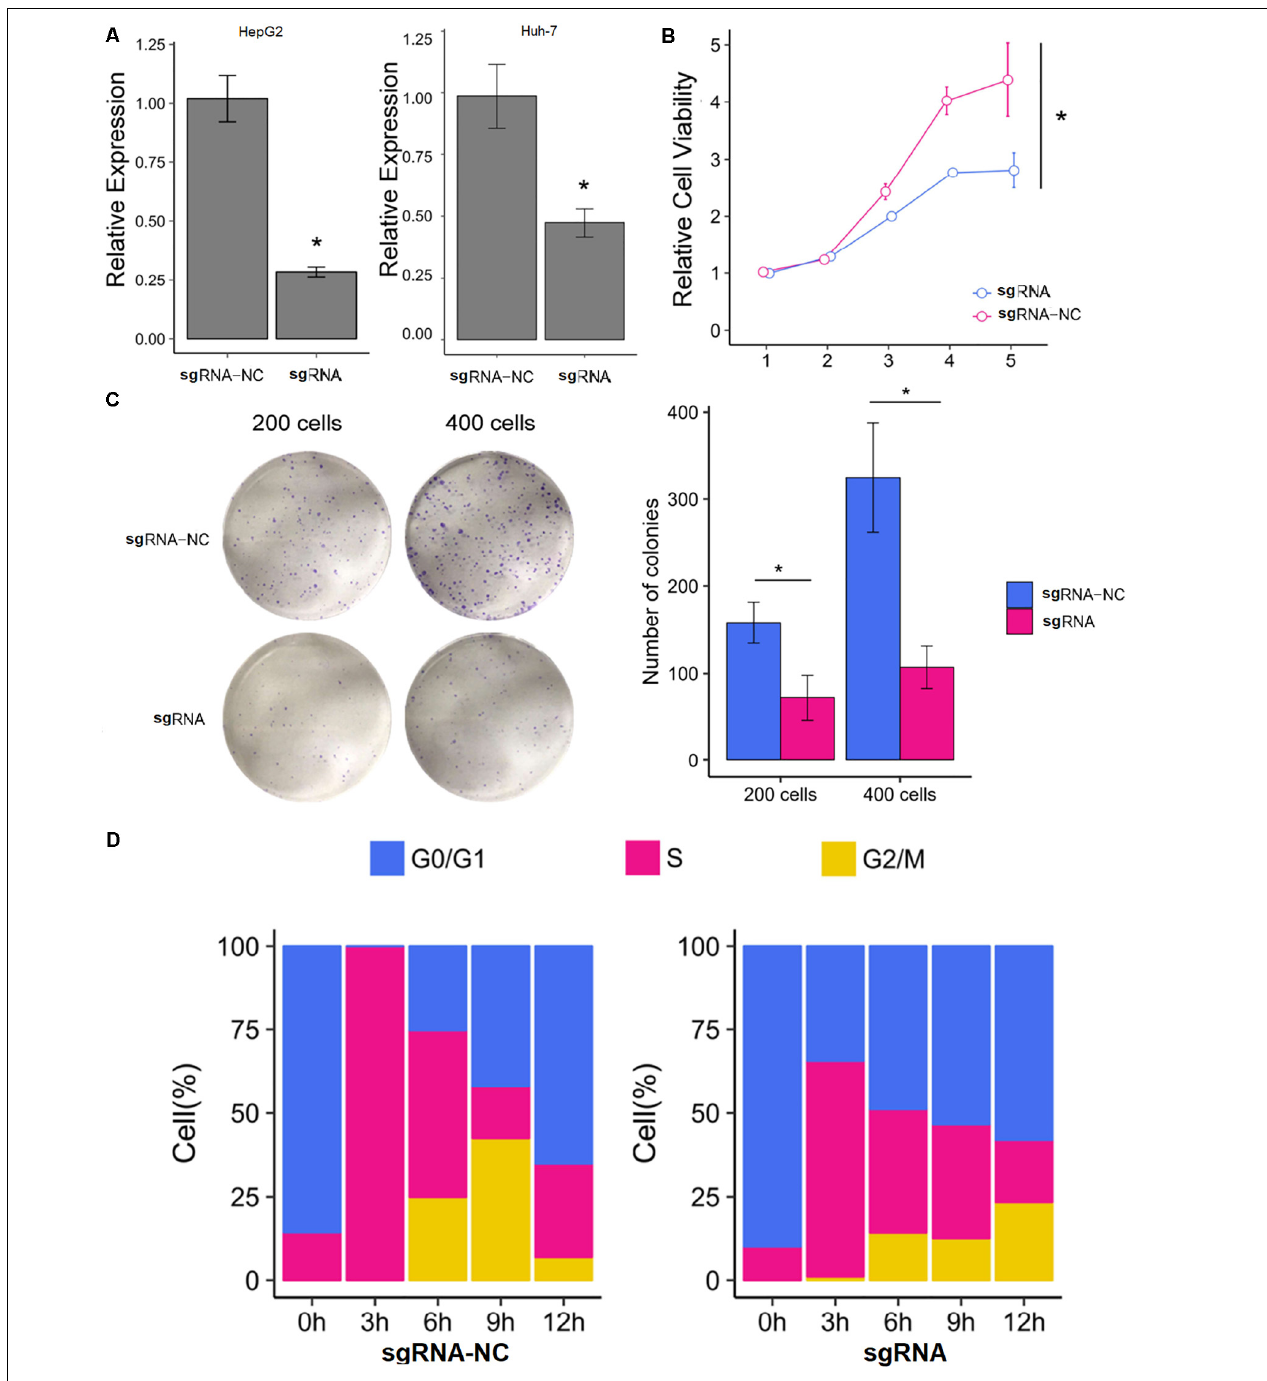
FIGURE 2 | Knockdown of SNHG9 can inhibit the proliferation and cell cycle progression of HCC cells. (A) The expression of SNHG9 in sgRNA-NC and sgRNA-SNHG9 transfected cells as detected by RT-qPCR. ( n = 3 independent experiments). (B) The CCK-8 method was used to evaluate the effect of silencing SNHG9 on cell proliferation. ( n = 3 independent preparations) * P < 0.05. (C) Clones are stained with Giemsa and photographed with a digital camera. The clone number was calculated and statistically analyzed. (D) The cell cycle was synchronized with the use of a double thymine block. The stack diagram shows the percentage of cells in each cycle at each time point. Left: Cells transfected with sgRNA-NC. Right: Cells transfected with sgRNA-SNHG9. Blue: Phase G0. Red:S phase. Gold:G2 and M